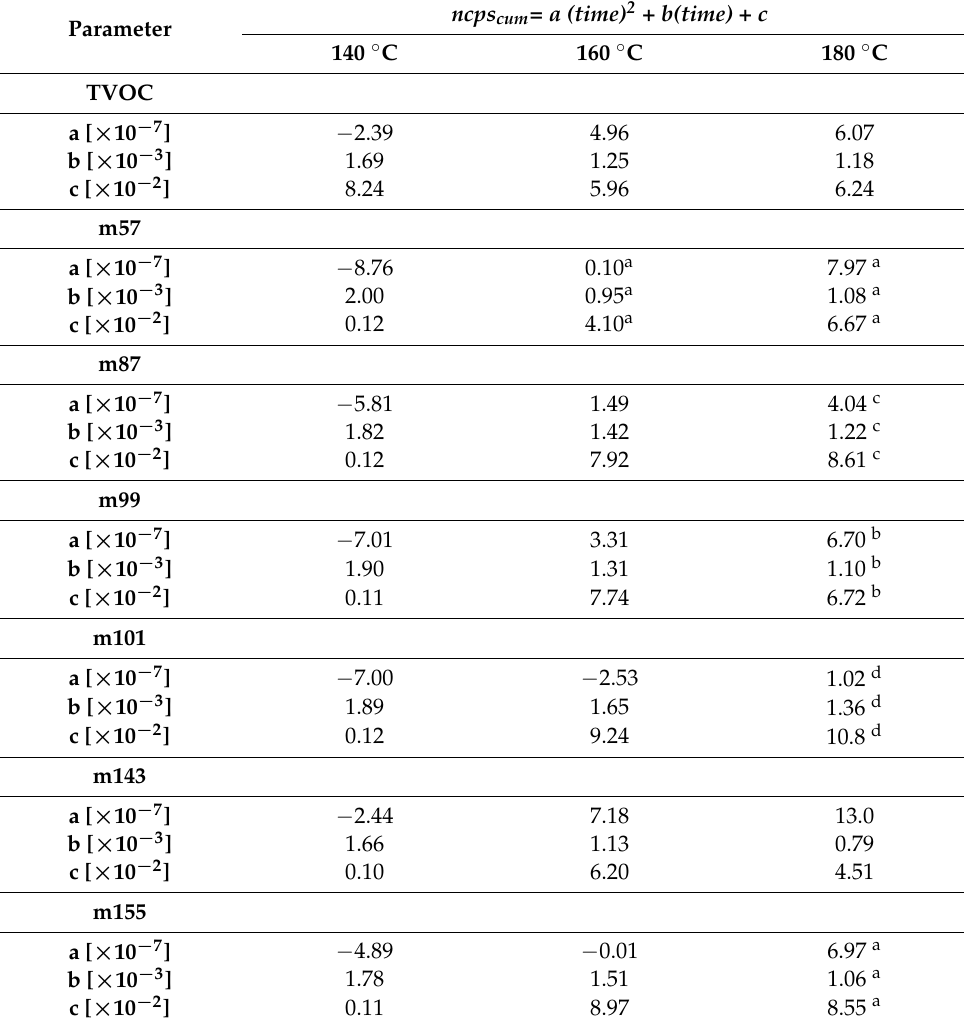
Table 2. Quadratic function parameters describing cumulative release kinetics curves of rapeseed oil SOPs (secondary oxidation